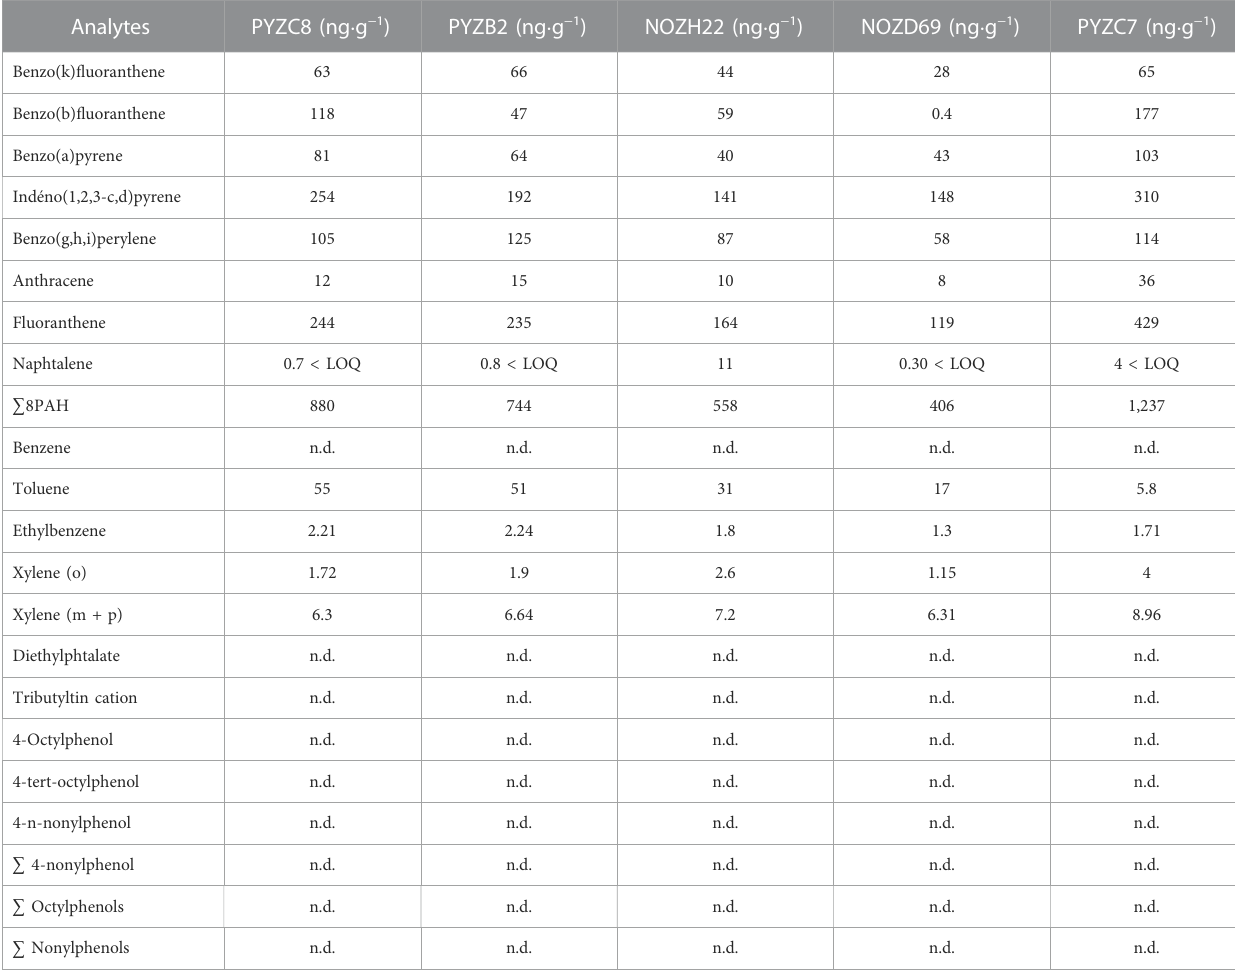
TABLE 4 Mean concentrations of organic contaminants measured in soil samples.